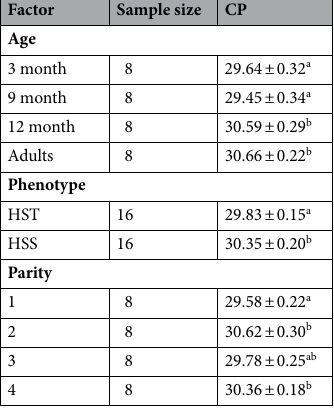
Table 6. The least squares means showing the effect on crossing point value (CP) in Jamunapari goats. CP Crossing point value; HST Heat-stress tolerant phenotype; HSS Heat-stress-susceptible phenotype; Means ± SE Means ± Standard Error, means within the same rows with different superscripts are significantly different ( p < 0.01).